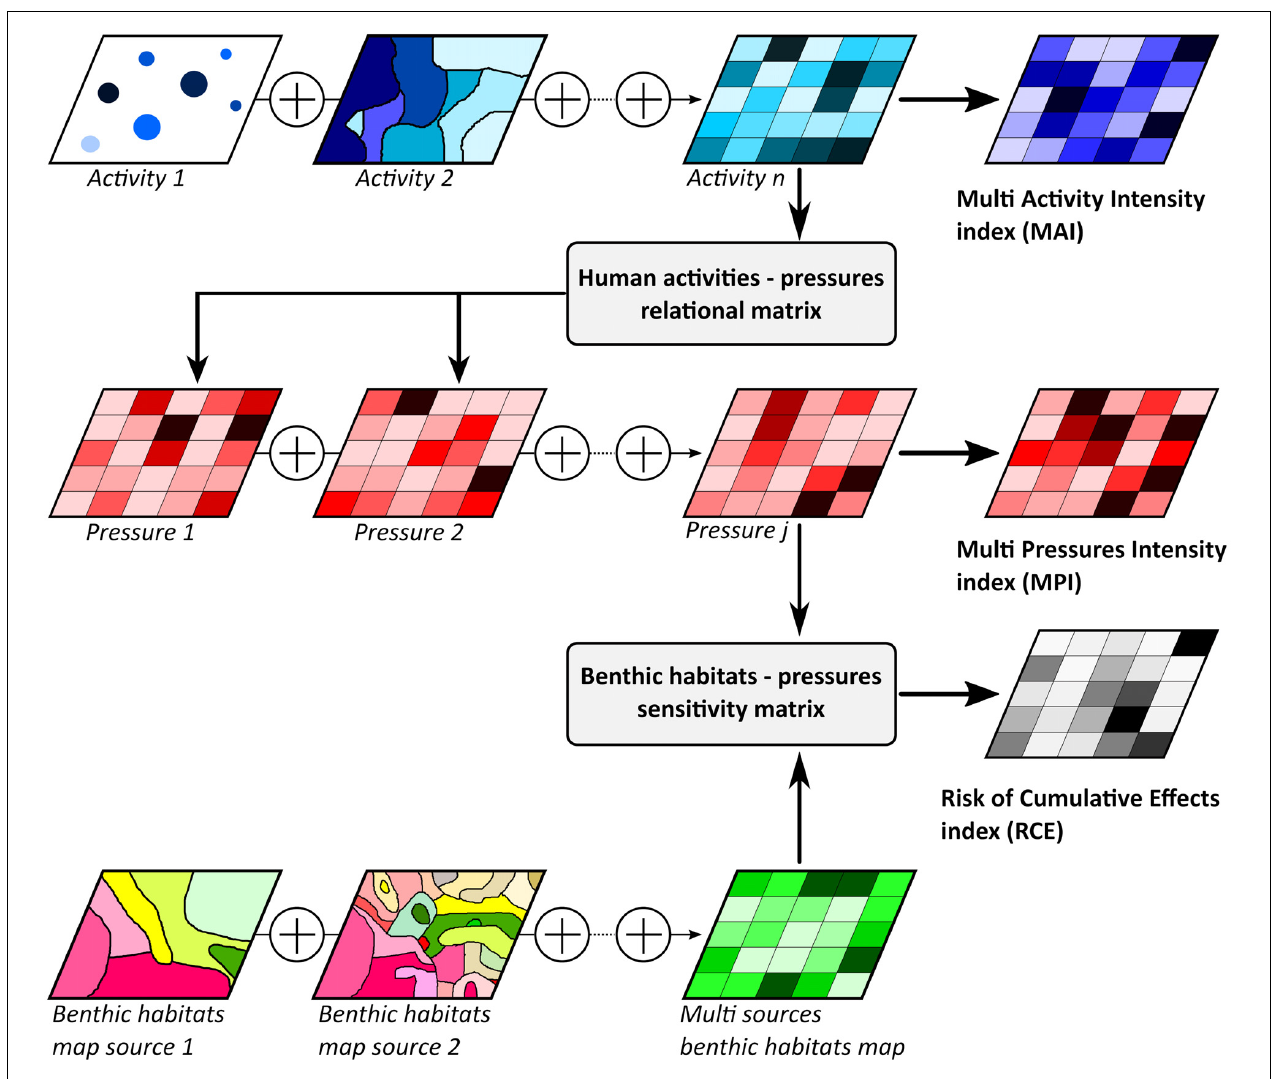
FIGURE 2 | Main steps of the RCE